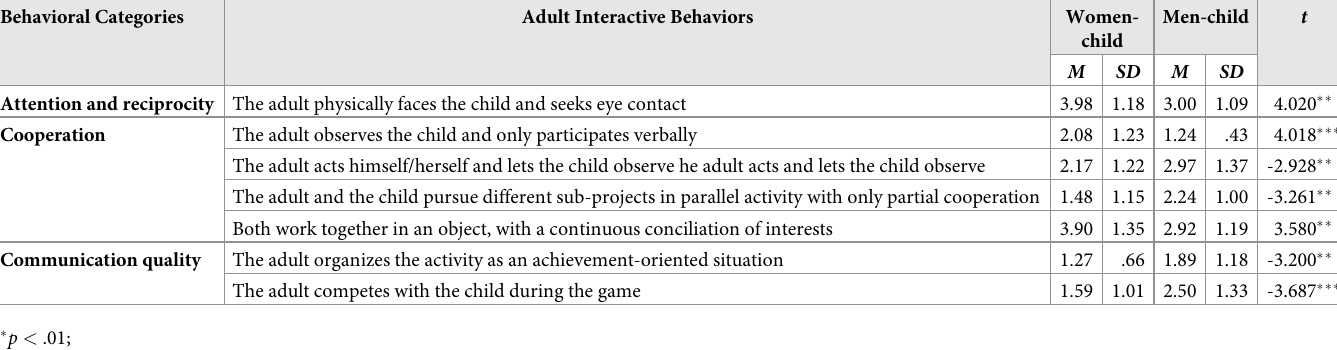
Table 6. Descriptive statistic and results of group differences test according to gender (women vs men) for adult interactive behaviors. Behavioral